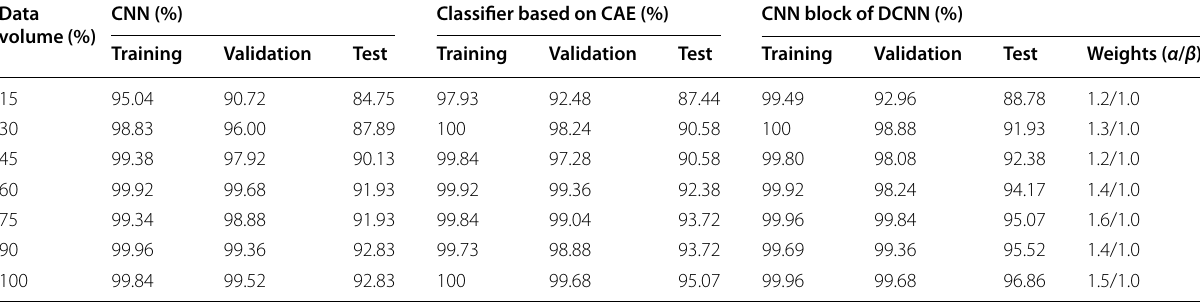
Table 2 Comparisons under different training samples size Data CNN volume (%)